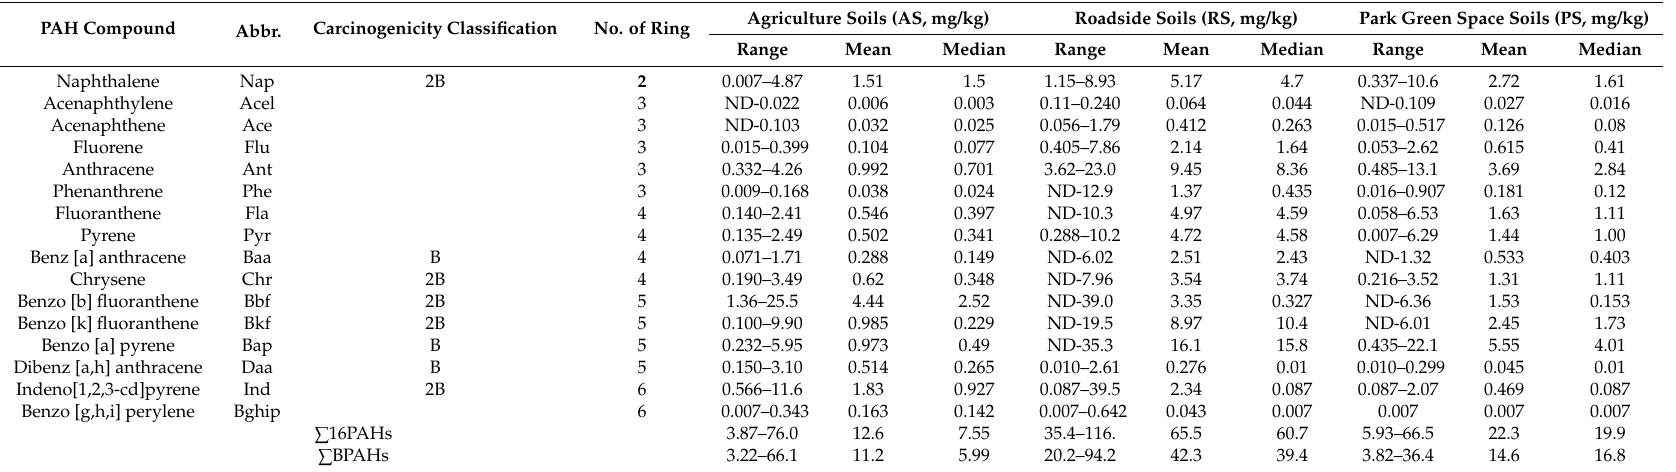
Table 1. Concentrations of individual PAHs, ∑ 16PAHs and ∑ BPAHs in the samples from agricultural soil (AS), roadside soil (RS) and parkgreen space soil (PS) around the chemical